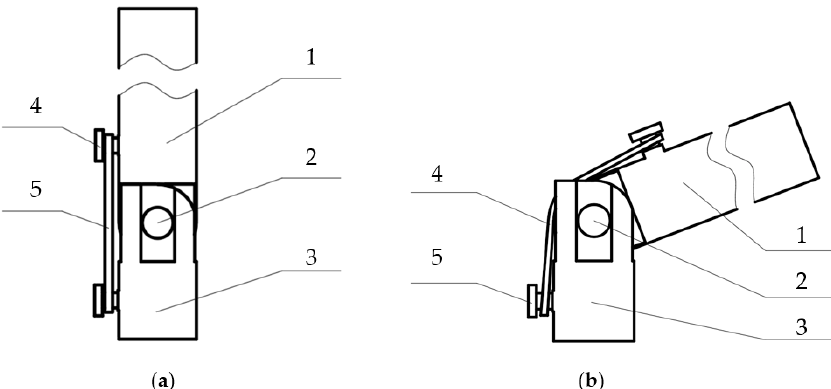
Figure 7. The mechanical structure of scale ( a ) the stand state; ( b ) the folded state (1—upper section, 2—shaft, 3—lower section, 4—elastic band, 5—fixing bolt).